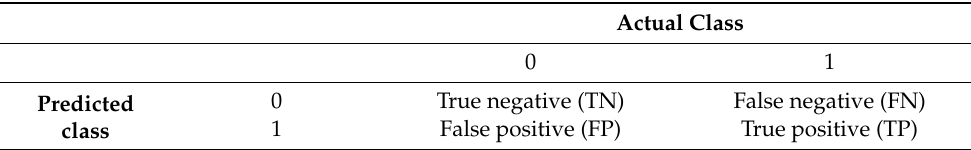
Table 4. Confusion